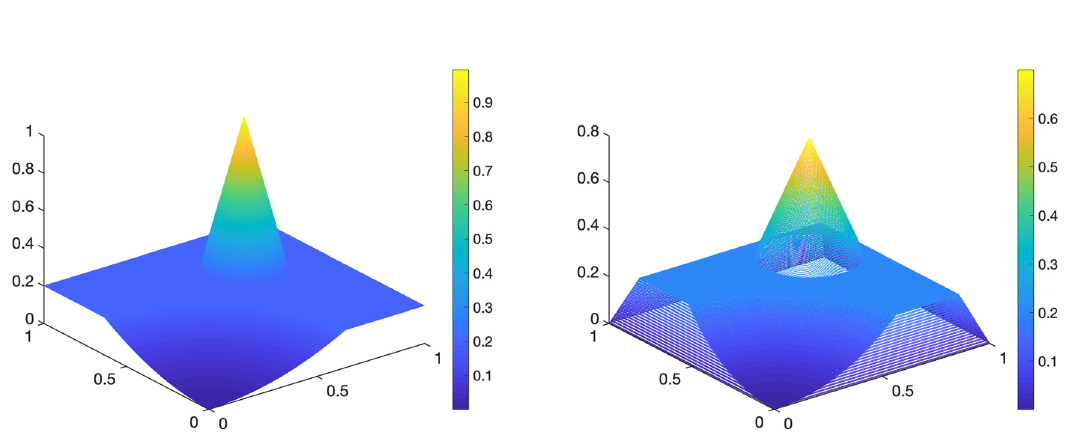
Figure 5: Example 2 ( α 2.5 = ) . Left panel: f . Right panel: the computed solution u h